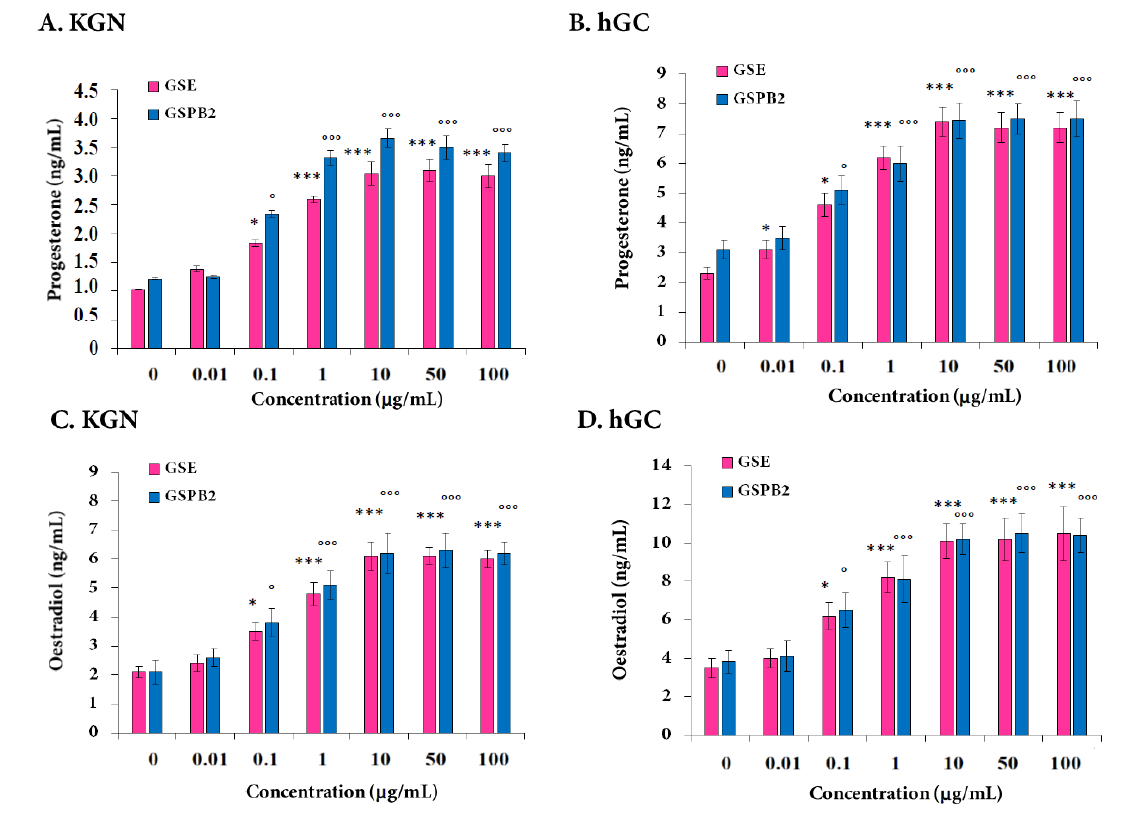
Figure 7. E ff ect of the GSE and GSPB2 treatments on progesterone ( A , B ) and estradiol ( C , D ) secretion by human granulosa cells. KGN ( A , C ) and hGC ( B , D ) cells were cultured for 48 h in medium with serum in the presence or in the absence of various doses of GSE and GSPB2. Progesterone ( A , B ) and estradiol ( C , D ) contents in the culture medium were then determined by ELISA. Results are expressed as ng / mL / 100 µ g protein. Results are reported as means ± SEM of three independent experiments. * and *** represent a significant e ff ect of GSE as compared to the control at p < 0.05 and p < 0.001, respectively. ◦ and ◦◦◦ represent a significant e ff ect of GSPB2 as compared to the control at p ≤ 0.05 and p ≤ 0.001,